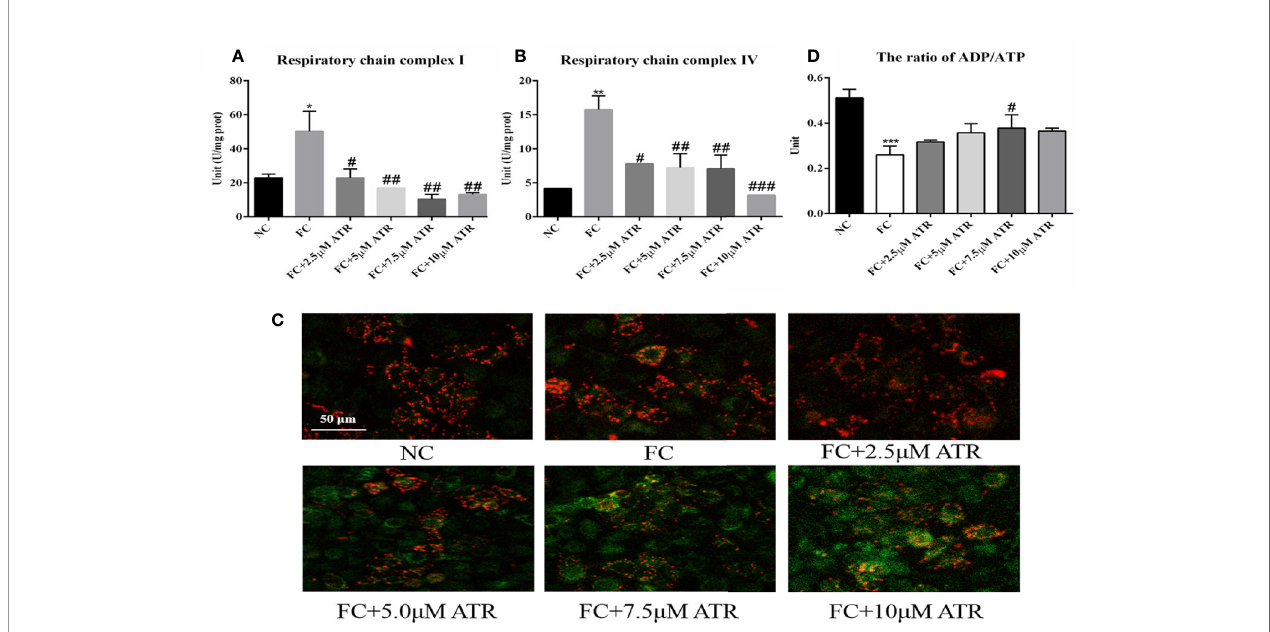
FIGURE 3 | Mitochondrial adaptation effect of ATR on FFA-treated HepG2 cells. (A) Activity of mitochondrial respiratory chain complex I. (B) Activity of mitochondrial respiratory chain complex IV. (C) Changes in JC-1 fl uorescence in response to ATR (red fl uorescence represents normal mitochondrial membrane potential and green fl uorescence represents decreased mitochondrial membrane potential). (D) Ratio of ADP/ATP. Data are expressed as mean ± SD (n=3). *P<0.05, **P<0.01, ***P<0.001 (*represents the FC group compared with the NC group). # P<0.05, ## P<0.01, ### P<0.001 ( # represents FC+ATR treatments compared with the FC group). NC=normal group, and FC=FFA group.